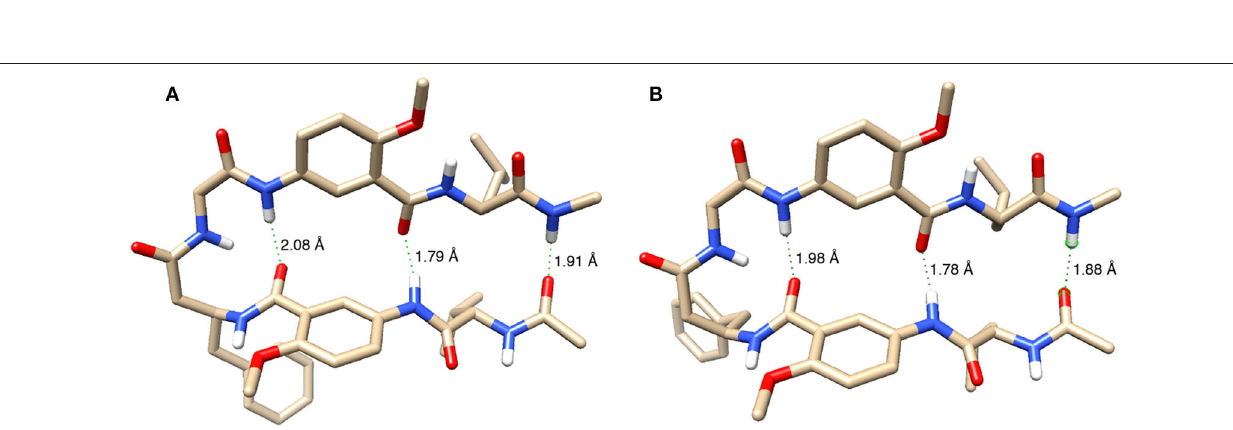
Frontiers in Chemistry | www.frontiersin.org